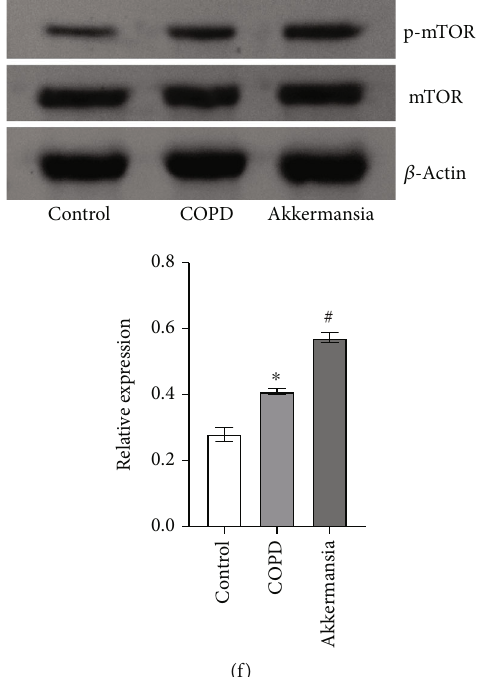
Figure 6: Akkermansia muciniphila improves lung tissue injury and autophagy in COPD mice. (a) HE staining was used to observe lung tissue injury. (b) The levels of IL-17A, IL-6, and TNF- α in blood were detected by ELISA. (c) The expression of cleave-caspase 3 and TROP2 was analyzed by IHC. (d) The expression of LC3 was detected by IF. (e, f) The expression of p62, LC3II/I, p-mTOR, and mTOR protein in lung tissue was analyzed via western blot. ∗ P < 0 : 05 vs. control; # P < 0 : 05 vs.